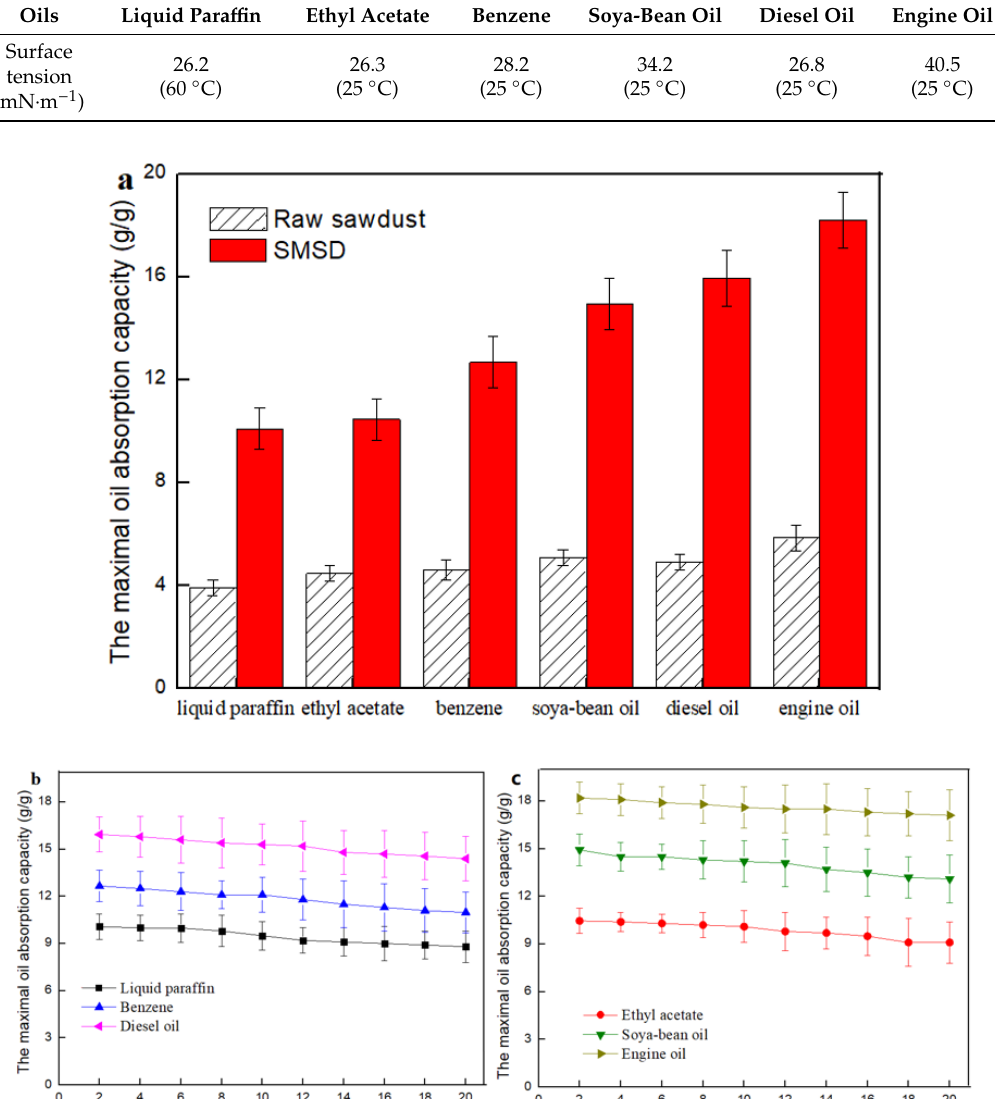
Figure 9. The maximum oil absorption capacity with SMSD: ( a ) for di ff erent oils in the first cycle; ( b , c ) after di ff erent